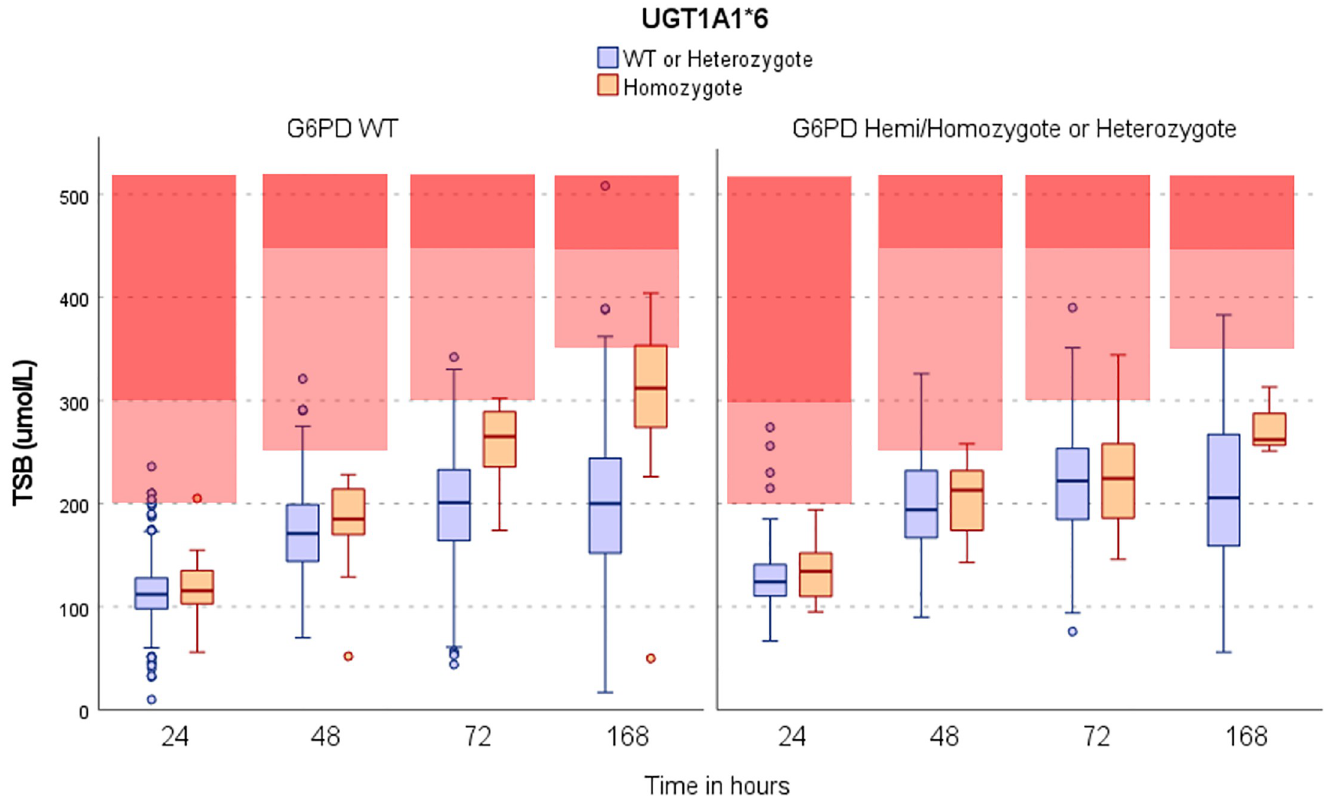
Fig 3. Total serum bilirubin concentrations in neonates with EGA � 38 weeks: UGT1A1 � 6 genotype (homozygote vs non-homozygote) in G6PD hemi-homo/ heterozygote group and wild type group. TSB = Total Serum Bilirubin; Boxes represent inter quartile ranges; middle horizontal lines are medians Red areas represent TSB values at which phototherapy (light red) and exchange transfusion (darker red) should be provided based on neonates’ age (NICE guideline). One data point (TSB = 1072 μ mol/L) at 168h in the right panel among UGT1A1 � 6 WT-heterozygote is not shown.